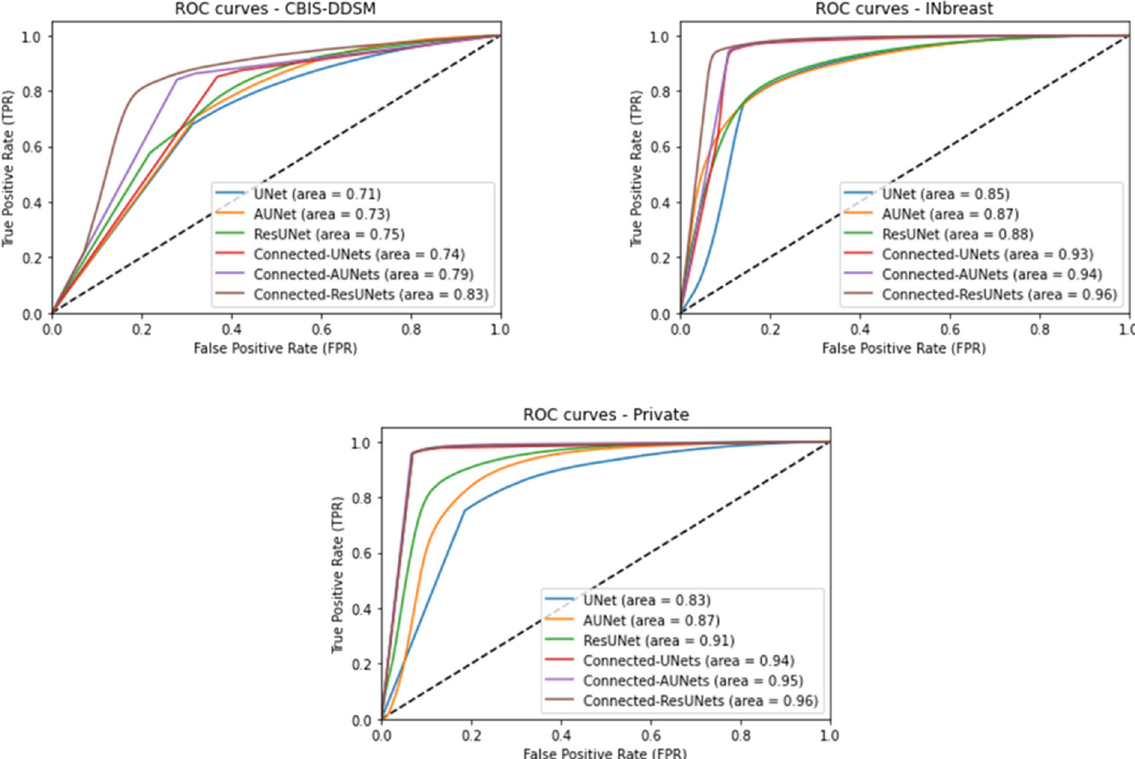
Fig. 1 Performance of mass segmentation using the different architectures in terms of ROC curves on the test sets of CBIS-DDSM, INbreast, and the private datasets. ROC curve plots with True positive Rate (TPR) against the False Positive Rate (FPR) and area under curve for pixel-wise evaluation of the standard models (UNet, AUNet, and ResUNet) and for the proposed architecture models (Connected-UNets, Connected-AUNets, and Connected-ResUNets). Subplot on the left shows ROC curve plot for the CBIS-DDSM dataset. Subplot on the right shows ROC curve plot for the INbreast dataset. Subplot on the bottom shows ROC curve plot for the private